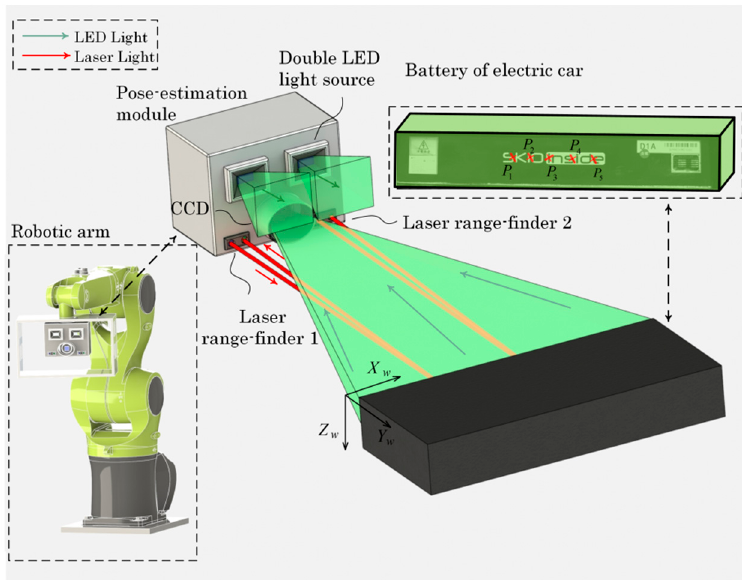
Figure 1. System layout of pose-estimation system; the pose-estimation module is fixed on the robot manipulator; The pose-estimation module, composed of Charge Coupled Device (CCD) camera, two laser rangefinders and two LED light sources; The battery of electric car with printing pattern.